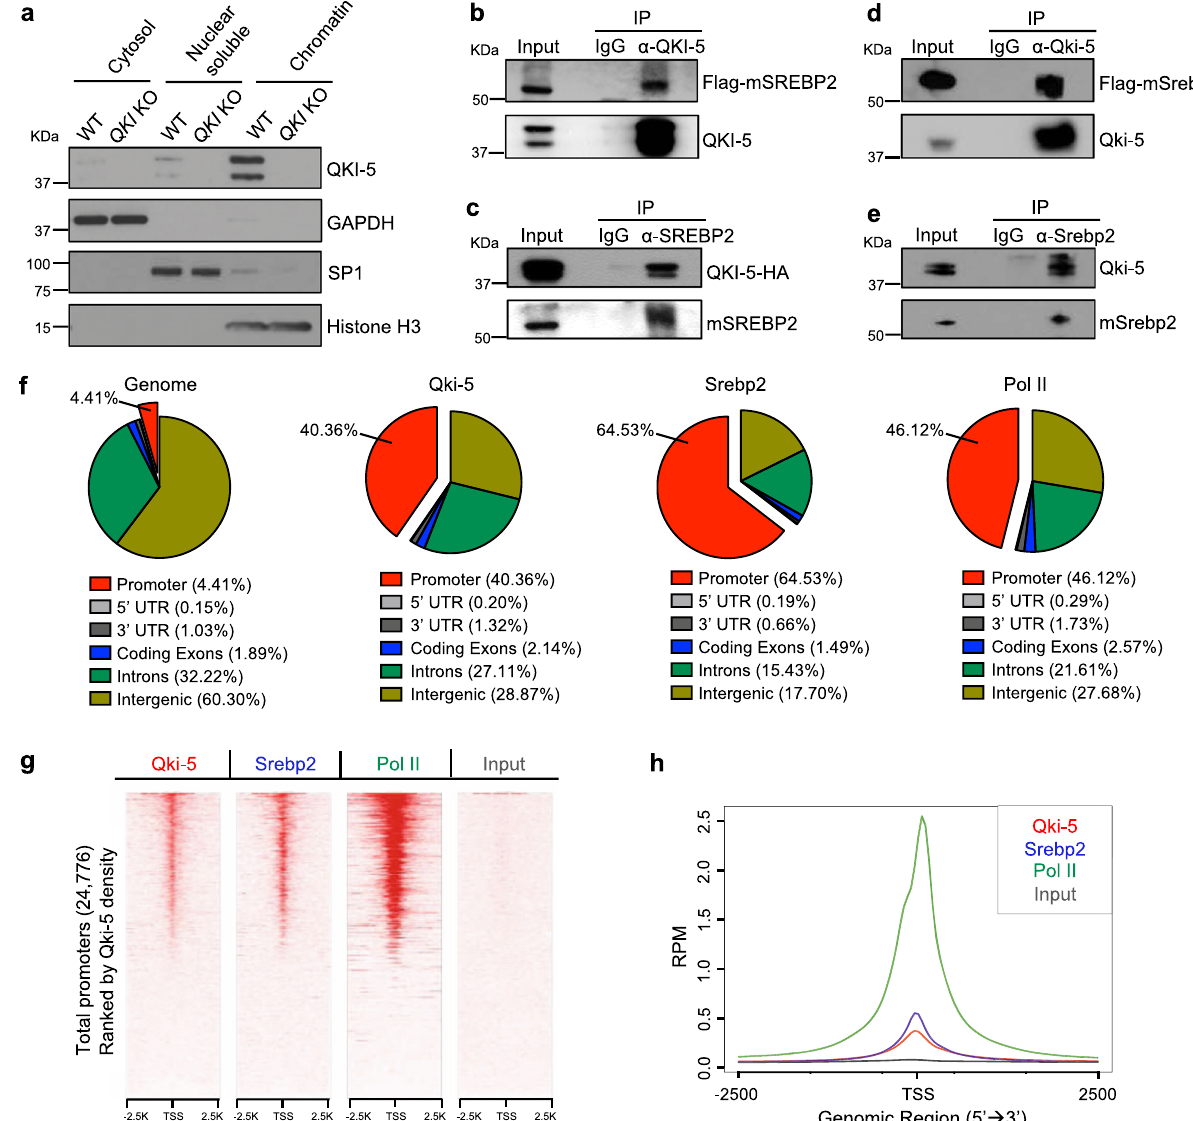
Fig. 4 QKI-5 cooperates with SREBP2 at promoters genome-wide in lens cells. a Immunoblots of QKI-5 in subcellular fractions of WT and QKI KO HLE- B3 cells. GAPDH: cytosol; SP1: nuclei; Histone H3: chromatin. The result was repeated three times. b , c Co-IP of HLE-B3 cells overexpressing QKI-5 – HA and Flag-SREBP2 with b anti – QKI-5 antibody blotting with anti-Flag and – QKI-5 antibodies and c anti-SREBP2 antibody blotting with anti-HA and -SREBP2 antibodies. mSREBP2: mature SREBP2. The results were repeated three times. d , e Co-IP of NLPCs overexpressing Flag-Srebp2 with d anti – Qki-5 antibody blotting with anti-Flag and – Qki-5 antibodies and e anti-Srebp2 antibody blotting with anti – Qki-5 and -Srebp2 antibodies. The results were repeated three times. f Genomic annotation of genome or Qki-5 – , Srebp2-, and Pol II-binding sites from ChIP-seq in NLPCs. Promoters are con fi ned to the regions of ±2 kb from the TSS. g Heatmap of Qki-5, Srebp2, and Pol II ChIP-seq and input signals within ±2.5 kb from the TSS regions for all promoters ( n = 24,776) in NLPCs ranked by Qki-5 density. h Signalplots showing the read counts per million mapped reads (RPM) for Qki-5, Srebp2, and Pol II ChIP-seq data and input ±2.5 kb from the TSS of all promoter regions ( n = 24,776) in